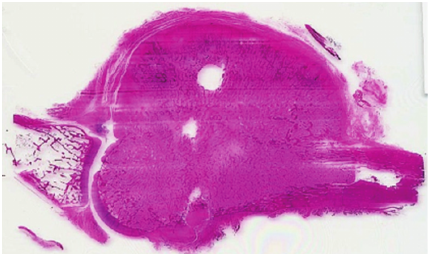
Figure 9: A whole mount of the lesional tissue showing the direct communication of the lesion with the host bone.